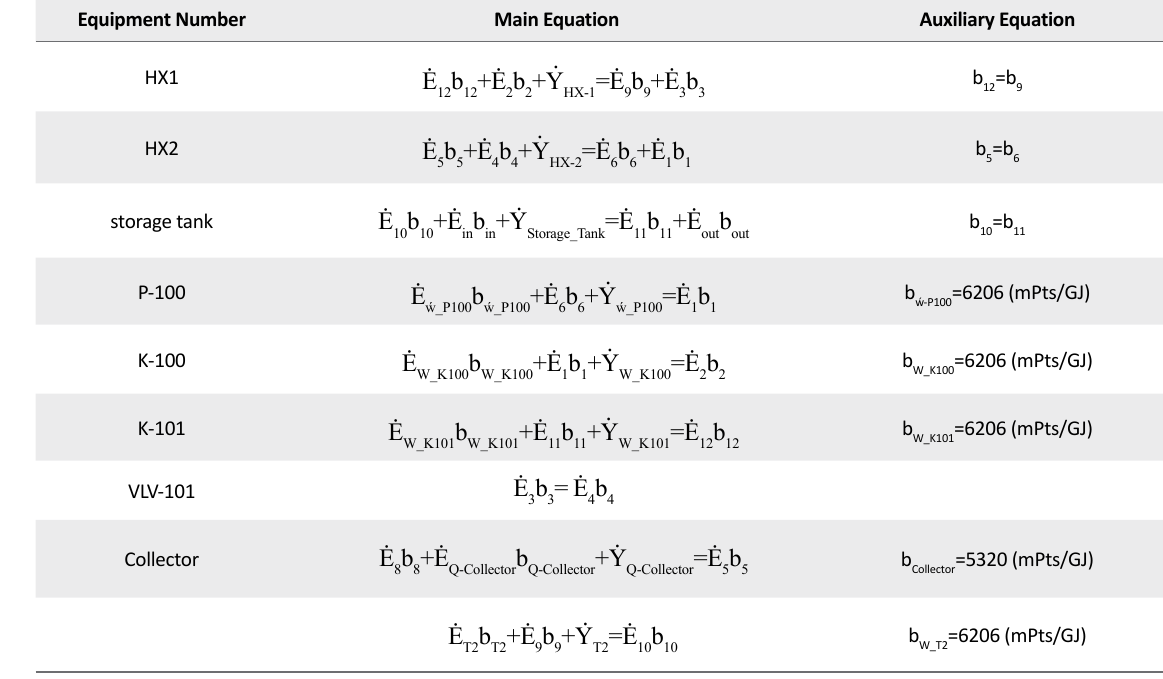
Table 10. The result of exergy analysis of the processing equipment.